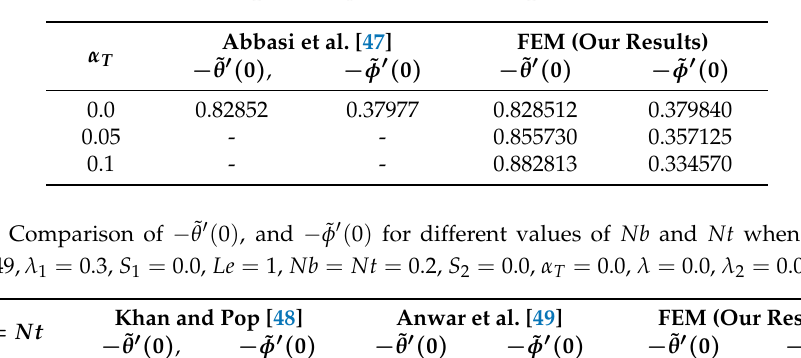
Table 4. Comparison of − ˜ θ (cid:48) ( 0 ) , and − ˜ φ (cid:48) ( 0 ) for different values of α T when Pr = 1, M = 0.49, λ 1 = 0.3,